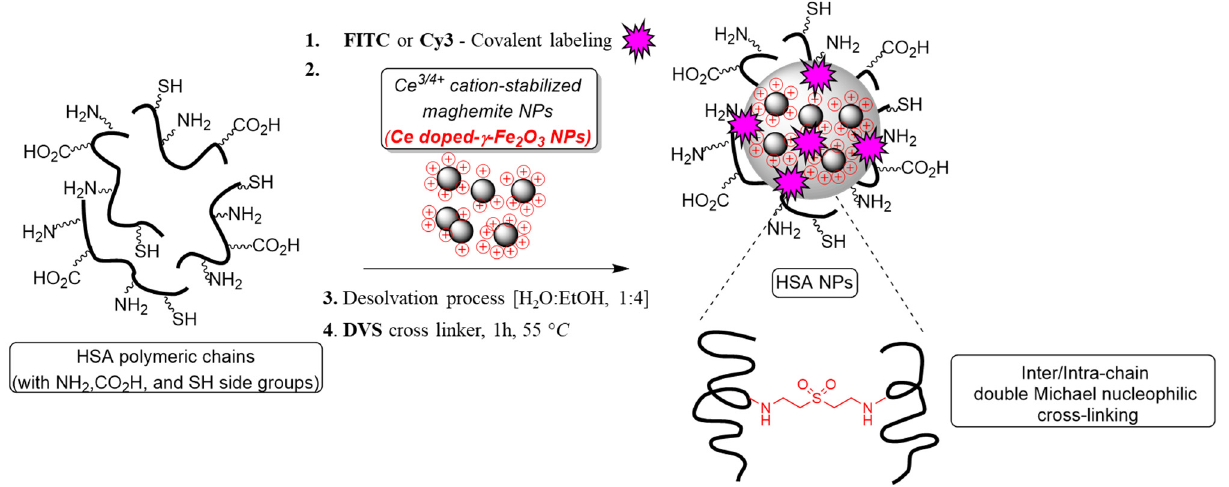
Figure 1. Schematic representation of the hMNP preparation